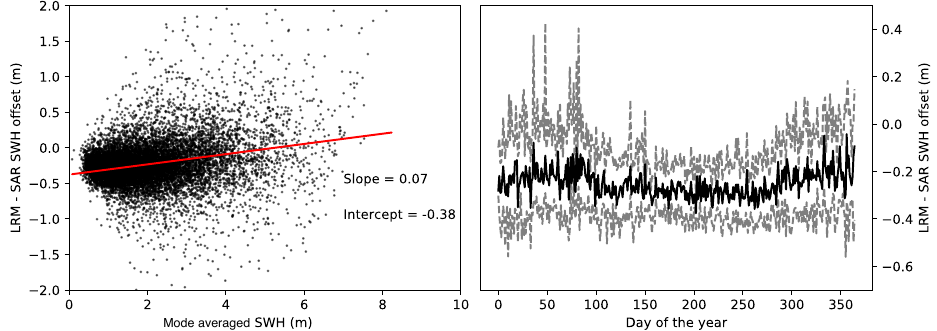
Figure 7. Difference between our retrieved SAR and LRM mode SWH 2011–2019. Plot to the left compares all coincident LRM and SAR mode SWH retrievals vs. the unscaled SWH. The plot to the right is the time series of 25th, 50th and 75th percentile of the LRM to SAR mode SWH offset. The best fit slope becomes closer to unity for all cases shown in Figure 8. For LRM mode, in the scatter plot between the raw data (top left), there is a visible correlation between the scatter and the green correction line of [17] for SWH < 1.5 m. The corrected version has no such shape and also has a best fit slope of near unity (0.97), and intercept of 0.01 m. As the analysis of [17] considers buoy data at lower latitudes, where CS2 operates in LRM mode, this result shows that our adjusted LRM SWH is in close correlation with existing corrected satellite SWH data. As our corrected LRM is matched to our raw SAR data this result (along with the improved slope to the SAR in the central column of Figure 8) shows that our SAR mode retrieved SWH is marked improvement on the pLRM processed RADS data, particularly in regions close to the sea ice